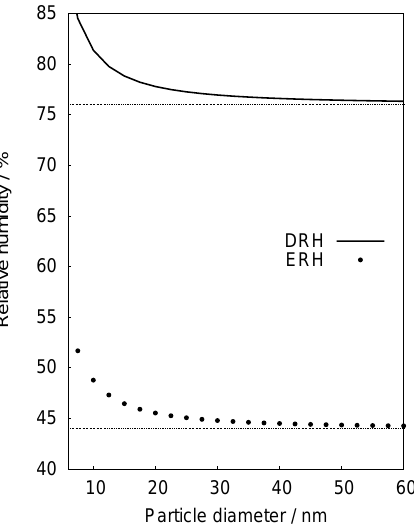
Figure 1. Empirically derived power law fits of the size depen- dence of the deliquescence and efflorescence relative humidity val- ues, DRH and ERH, of NaCl particles with dry mobility equivalent diameters in the range 6 < D m,dry / nm < 60 according to Eq. (9) experimentally determined by Biskos et al. (2006b).